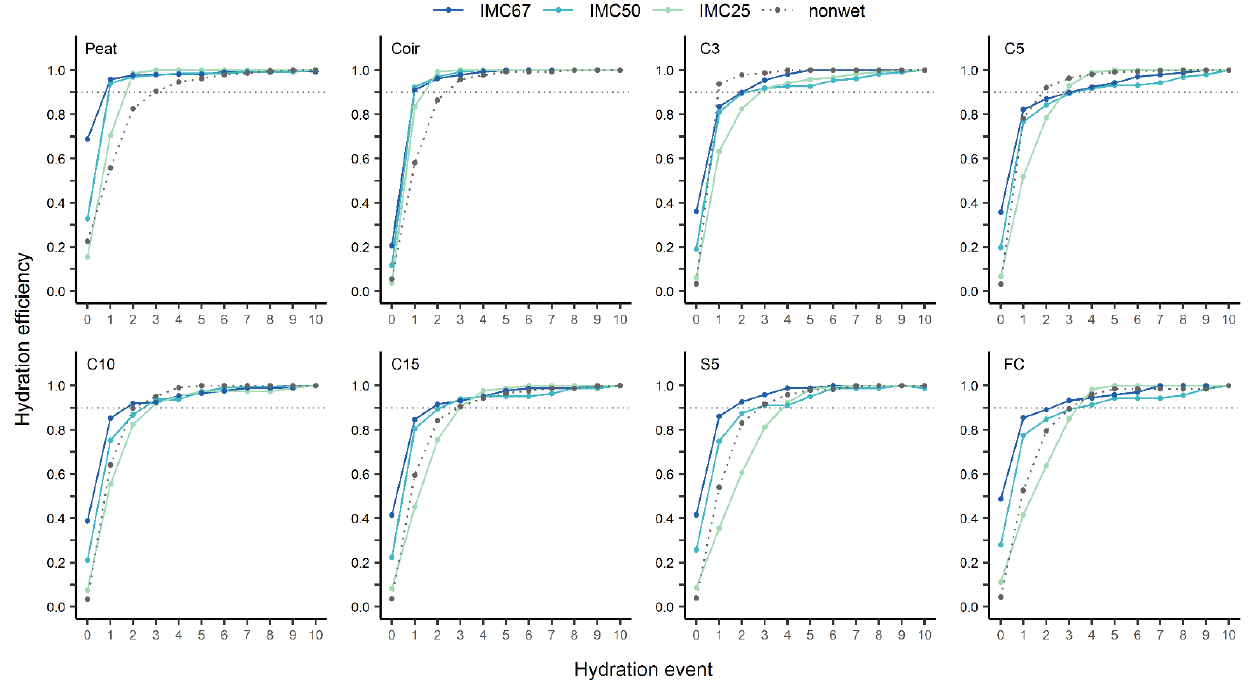
Figure 5. Hydration curves of peat, coir, and six processed miscanthus substrates at different initial moisture content (67% w, 50% w, 25% w, and non-wet). The curves are cumulative water retention (volume) after 10 successive hydration events. The reference lines are water holding capacity of the substrates. Each data point is a mean of 4 replicates. Miscanthus × giganteus was harvested with a forage harvester (FC, field-chips), then processed with a mechanical fraying facility through a 5-mm screen (S5, shreds) or a hammermill with screen sizes of 15, 10, 5, and 3 mm (C15, C10, C5, and C3, chips). Commercial peat substrate amended with 30% clay.